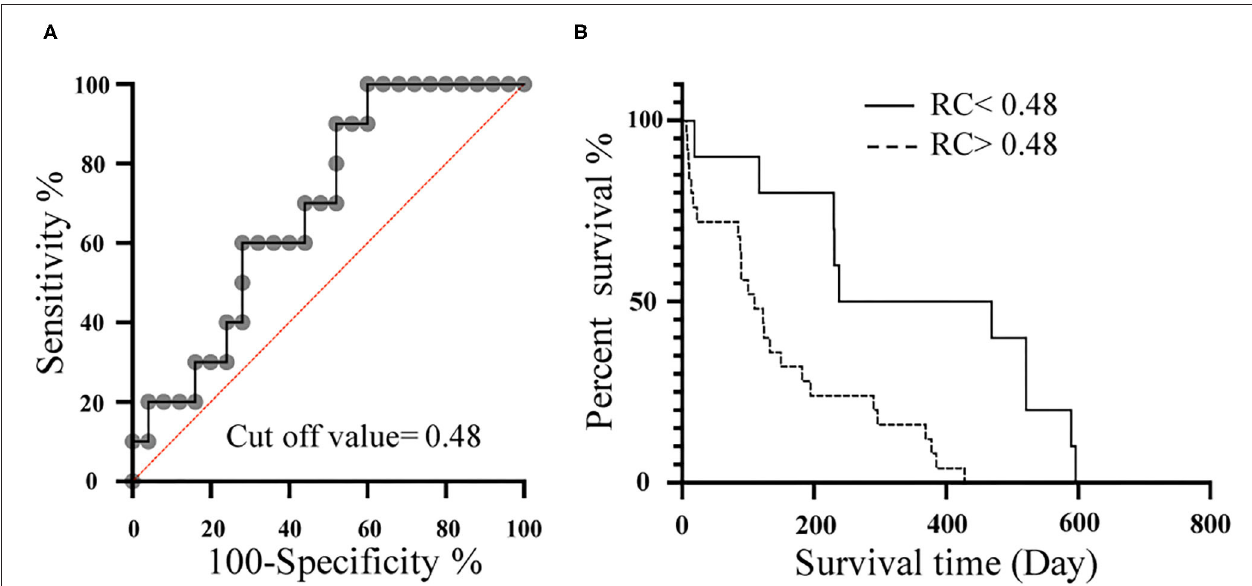
FIGURE 6 | Relationship between RC and prognosis. (A) , Receiver-operating characteristic (ROC) curves of RC for the detection of dogs with edema related with right heart failure (ascites, pleural effusion) among dogs with PH. (B) , Kaplan-Meier survival curve for 35 dogs stratified by RC. Dotted line represents RC > 0.48. Solid line represents RC < 0.48. RC, Reflection coefficient which calculated as the ratio of peak Pb to peak Pf; Pb, Backward pressure; Pf, Forward pressure.